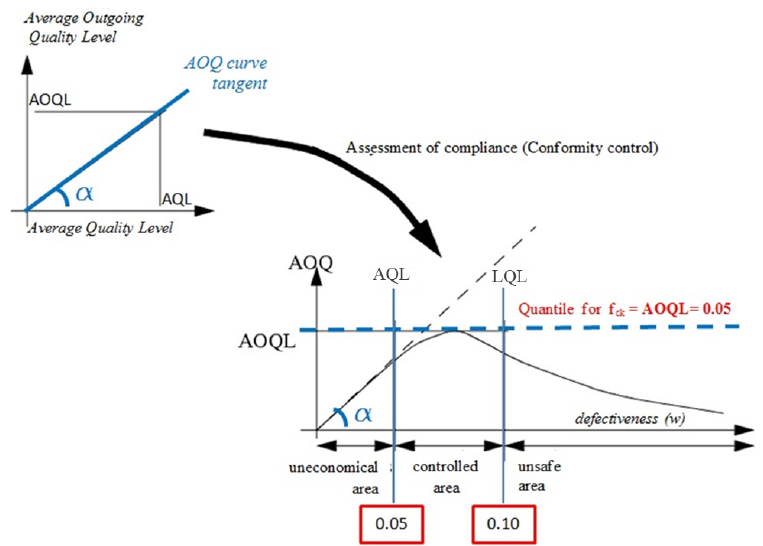
Figure 9. Diagram of the relationship between the defectiveness before and after quality control for compressive strength of concrete.